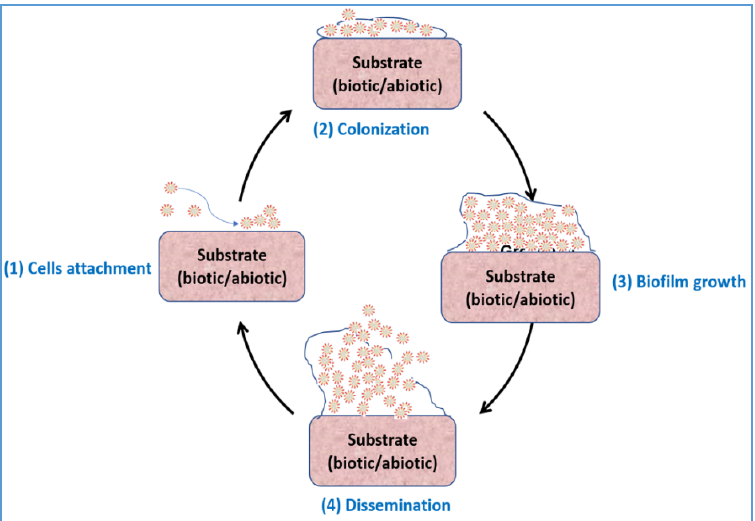
Figure 11. Growth of a virus biofilm. Initially, viruses settle down onto a surface that can either be inanimate or living tissue. Then, secretion of extracellular matrix allows the cells to colonize and anchor on the substrate. This step repeats itself, leading to biofilm growth. Finally, a fully developed biofilm with water channels allows oxygen and nutrients to penetrate to the biofilm and allows processes disseminating viruses into the environment for a long time.